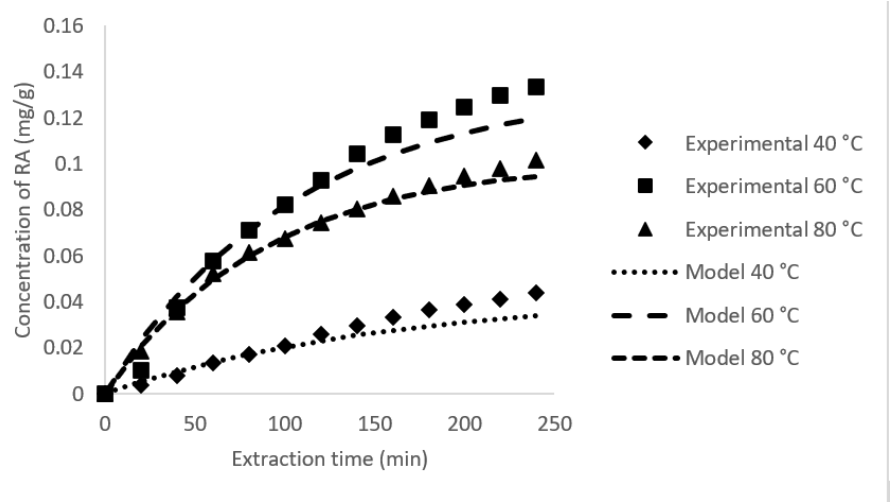
Figure 4. Extraction curve of RA extract from OS at constant pressure of 20 MPa.